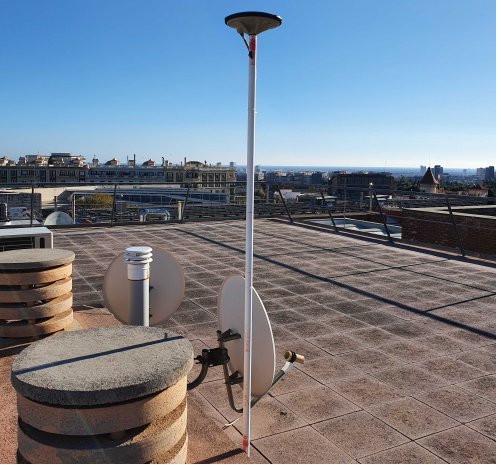
Figure 6. Antenna location for snapshot data